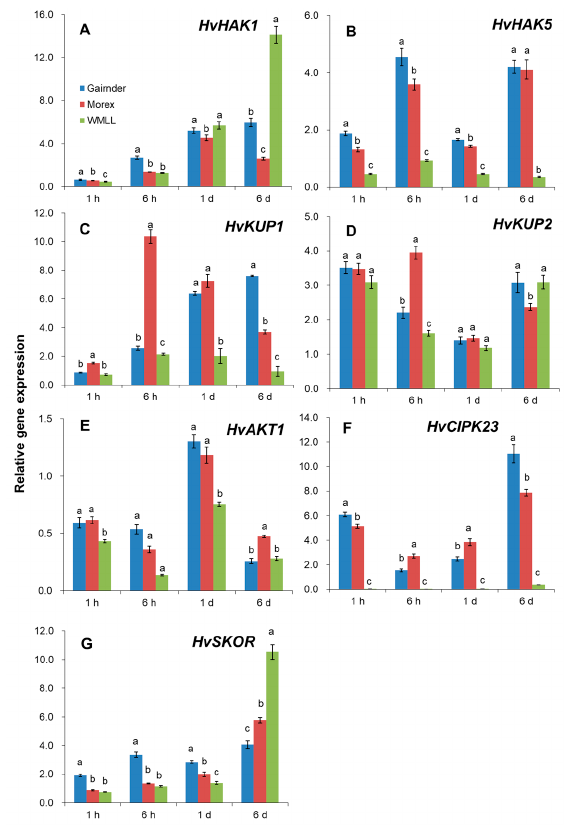
Figure 8. Transcript levels of genes conferring K + uptake [ HvHAK1 ( A ), HvHAK5 ( B ), HvKUP1 ( C ), HvKUP2 ( D ), HvAKT1 ( E ) and HvCIPK23 ( F )] and xylem loading [ HvSKOR ( G )] in barley roots after onset of drought stress generated by 20% PEG8000. Gene expression under control condition at each period was normalized to 1, and gene expression under drought condition at every sampling time was compared relative to it. Vertical bars represent means ± SE of three biological replicates. Di ff erent lowercase letters indicate the significant di ff erence between genotypes at p <